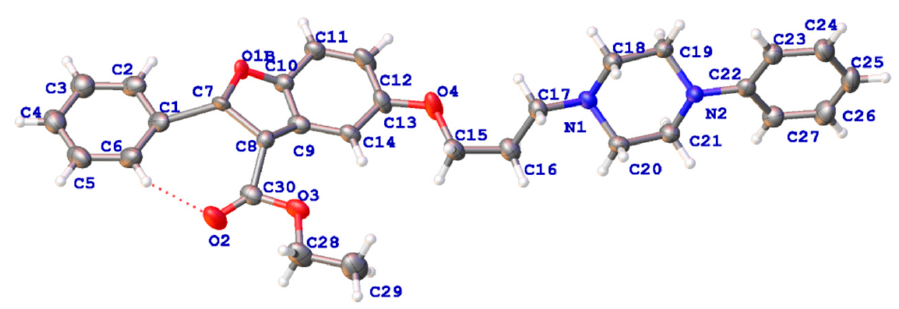
Figure 4. X-ray crystal structure of compound 4d .